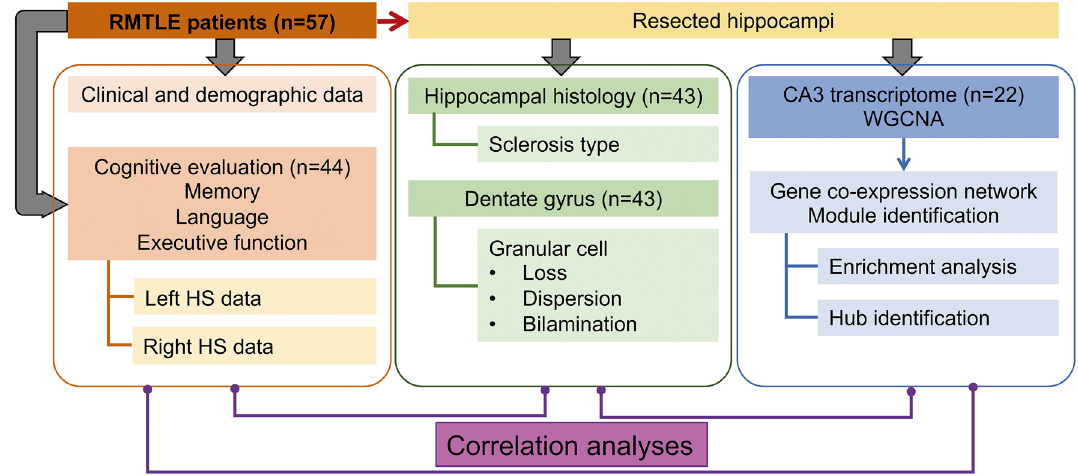
Figure 1. Study Workflow. Integrative analysis of demographic, clinical, histopathological, and genomic